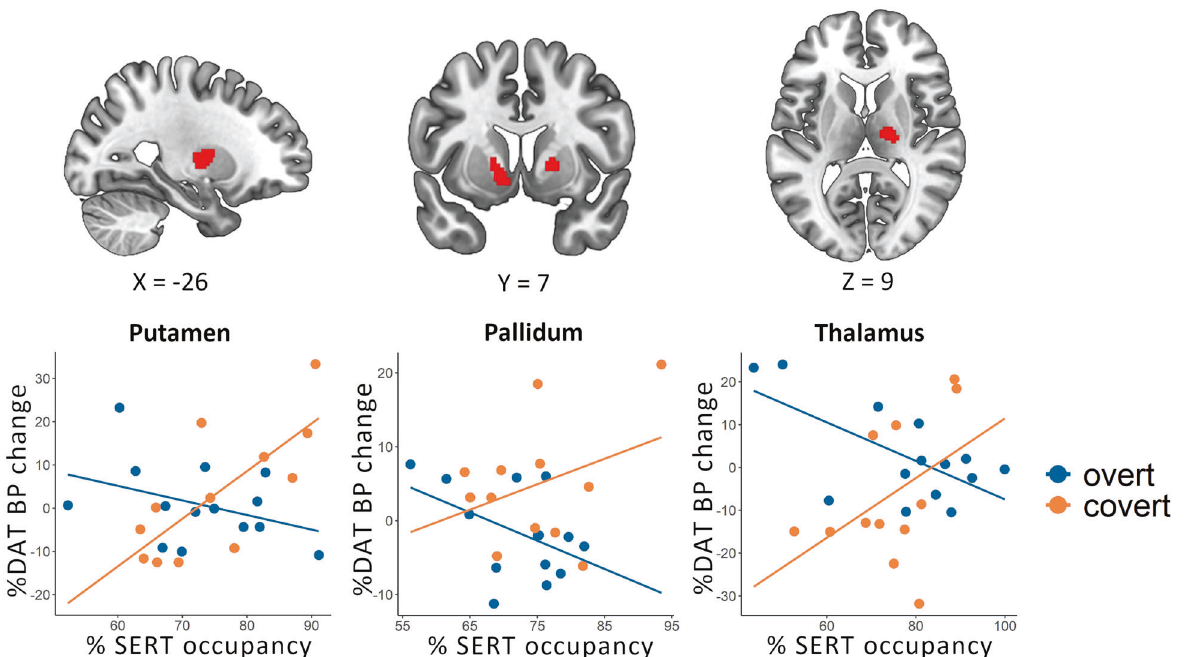
Fig. 3 Concomitant serotonin-dopamine transporter changes with overt and covert SSRI treatment. Signi fi cant group differences in correlations between percent sertonin transporter (SERT) occupancy and change in dopamine transporter binding (DAT BP) from pre-to post- treatment were noted in the left putamen, bilateral pallidum, and right thalamus (top panel). Scatterplots are shown in the lower panel. treatment, with almost a fourfold higher response rate, resulting in relatively lowered DAT binding in striatal and thalamic brain regions that correlated signi fi cantly with symptom improvement.